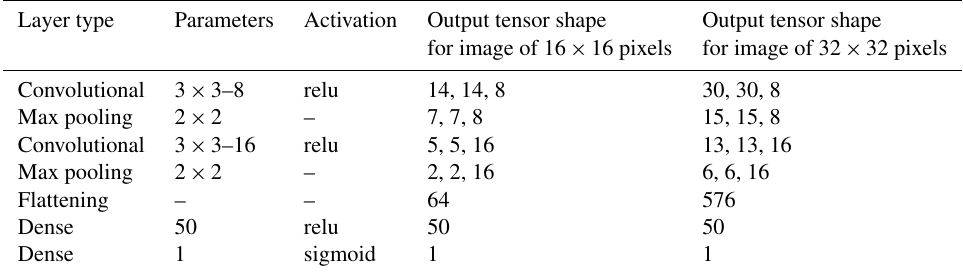
Table 3. The layers of our CNN. The convolutional layer parameter are denoted as “filter size” − “number of filters”, the stride is (1, 1), and no padding was added. The maximum pooling layer parameters are denoted as “pooling frame”. The fully connected layer parameters are denoted as “number of neurons”. For the activation function of the neurons, “relu” stands for the rectified linear unit, whereas “sigmoid” stands for the logistic sigmoid function. Output tensor shapes are also provided for each layer of the CNN for input images of size (16 × 16 × 8) and (32 × 32 × 8). The number of trainable parameters are 5053 for images of 16 × 16pixels and 30653 for images of 32 × 32pixels.